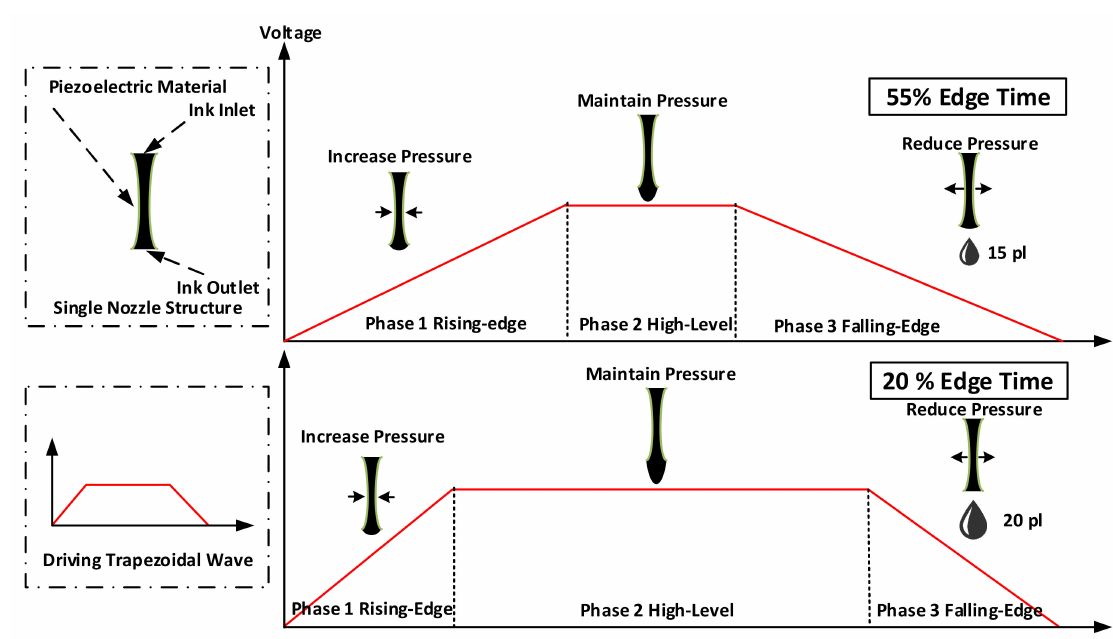
Figure 3. E ff ects of the nozzle structure based on simulations and on the di ff erent trapezoidal waves on the extruded droplets.